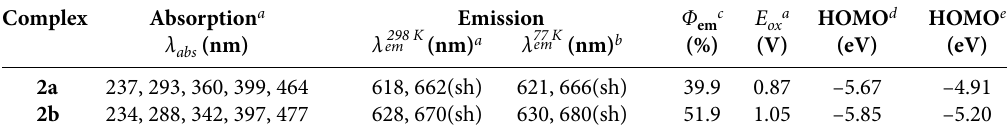
Table 4. Photophysical and electrochemical data of 2a – 2b . Complex